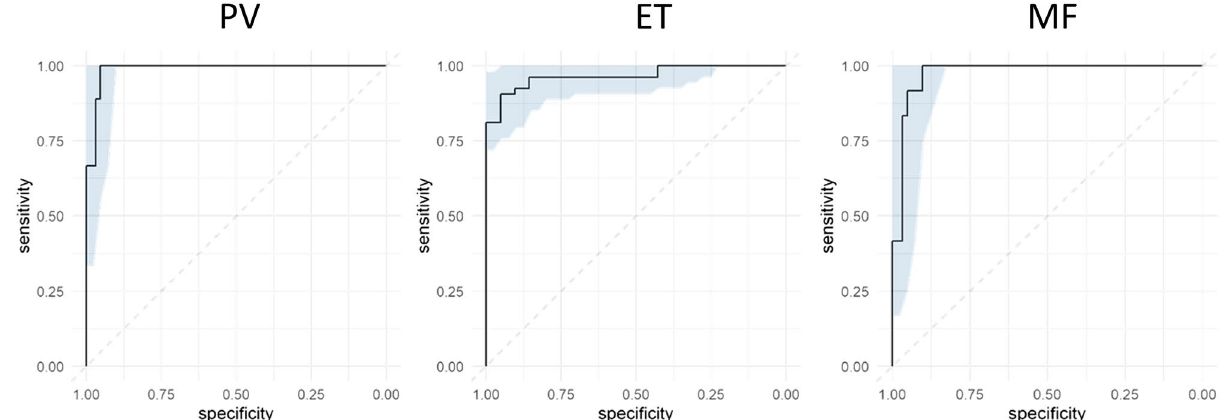
Figure 5. Differential diagnostic performance of the automated diagnostic support system. ROC curves for PV, ET, and MF. The AUC is used to measure performance; the maximum value is 1. Blue shades depict the 95% confidence intervals.